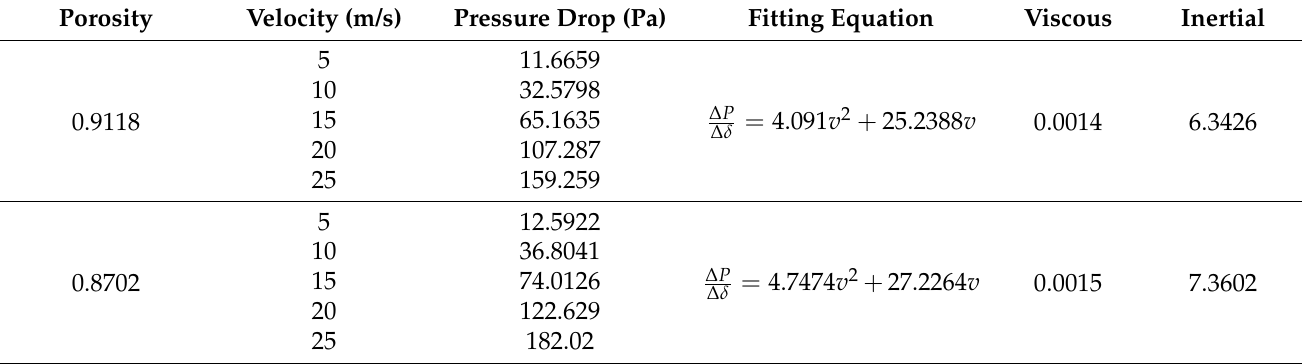
Table 2. Resistance